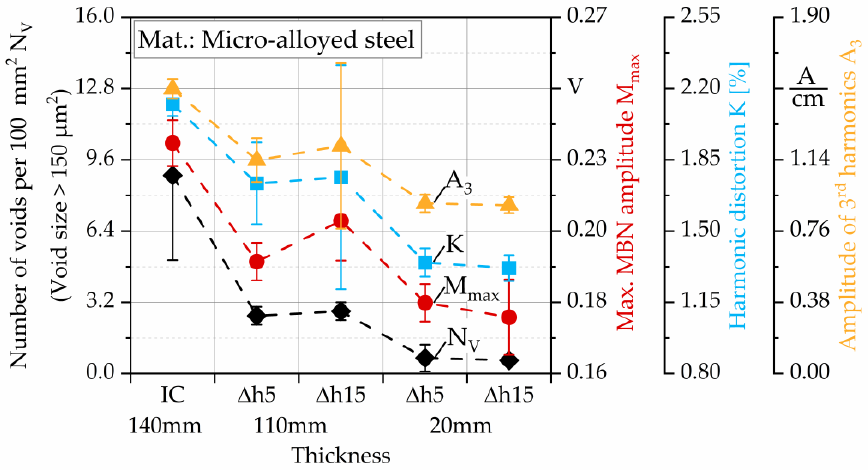
Figure 5. Maximum magnetic Barkhausen noise amplitude (M max ), harmonic distortion (K) and amplitude of 3 rd harmonics (A 3 ), correlated with the number of voids >150 µm 2 per 100 mm 2 (N V ) of hot flat rolled microalloyed mild steel. Number of voids from [6].